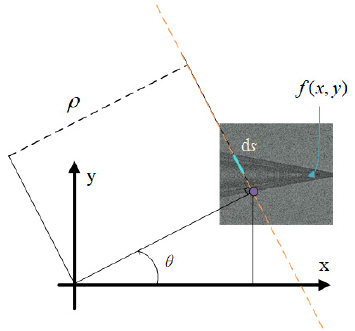
Figure 8. Schematic representation of the Radon transform.